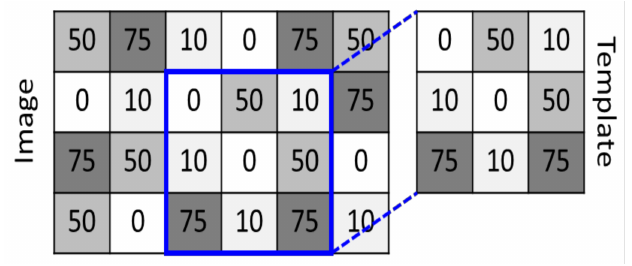
Figure 4. Example of a template